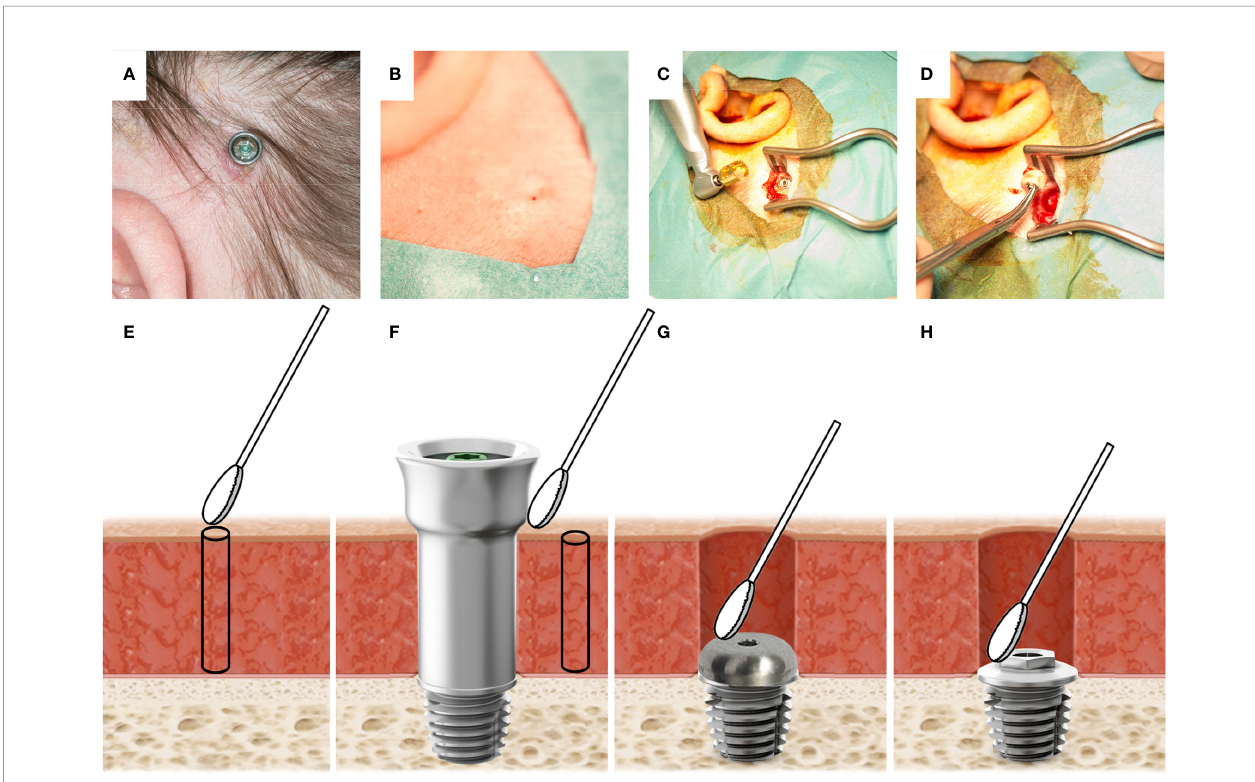
FIGURE 1 | (A) The BAHS with a mounted abutment at the 12-week follow-up. In the lower-left quadrant, a reddish moist irritated site can be observed. (B) The skin after abutment removal. No signs of in fl ammation are observed. (C) The implant in the bone during removal surgery. On the left: Trephine used to remove the implant is shown. (D) Retrieved implant with the surrounding bone. (E) Illustration of sampling performed at baseline prior to implantation where a skin swab (2x2 cm) is taken at the intended implantation site, prior to the retrieval of a 1 mm soft tissue biopsy using a 1 mm biopsy punch, (F) at 12 weeks, and during episodes with adverse skin reactions, a swab from the external side of the abutment and the peri-abutment skin are taken, and a 1 mm skin biopsy is retrieved. Finally, at implant removal, swabs were taken on the cover screw (G) and the top of the implant (H)